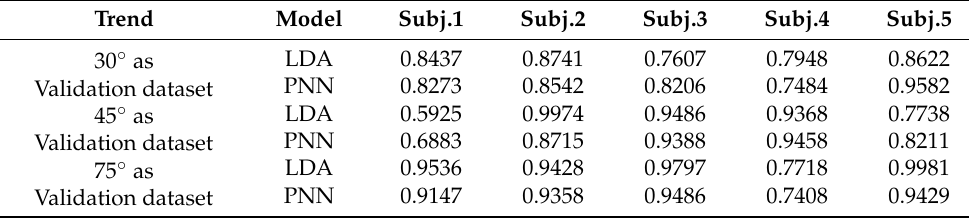
Table 4. Correlation analysis on each subject for the influence of forearm angle.